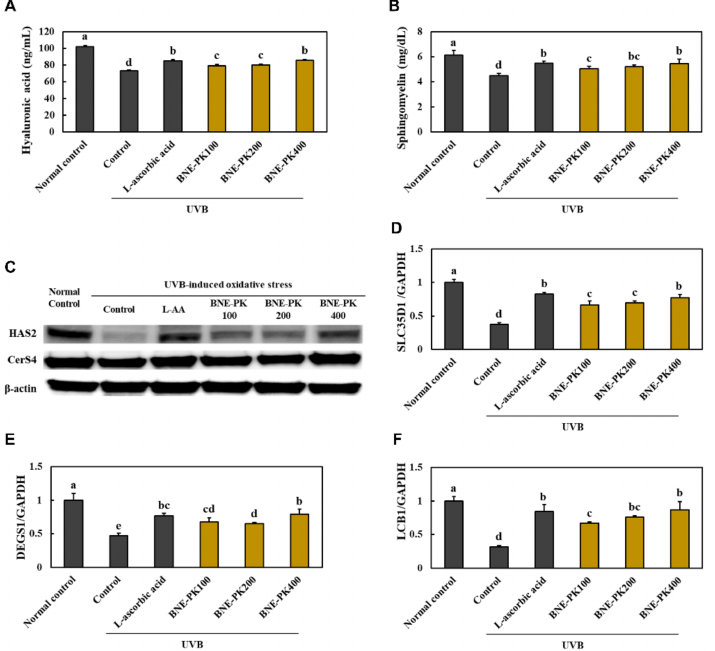
Figure 4. Effects of BNE-PK on the levels of hyaluronic acid ( A ) and sphingomyelin ( B ), protein expression of HAS2 and CerS4 ( C ), and mRNA expression of SLC35D1 ( D ), DEGS1 ( E ), and LCB1 ( F ) in ultraviolet B (UVB)-irradiated HaCaT cells. Normal control (NC; − UVB), control (C; +UVB), L-ascorbic acid (positive control; L-ascorbic acid treatment at 100 µ g/mL), and BNE-PK treatment at various concentrations (100, 200, and 400 µ g/mL). Values are presented as mean ± SD. Different letters indicate a significant difference, with p < 0.05, as determined with Duncan’s multiple range